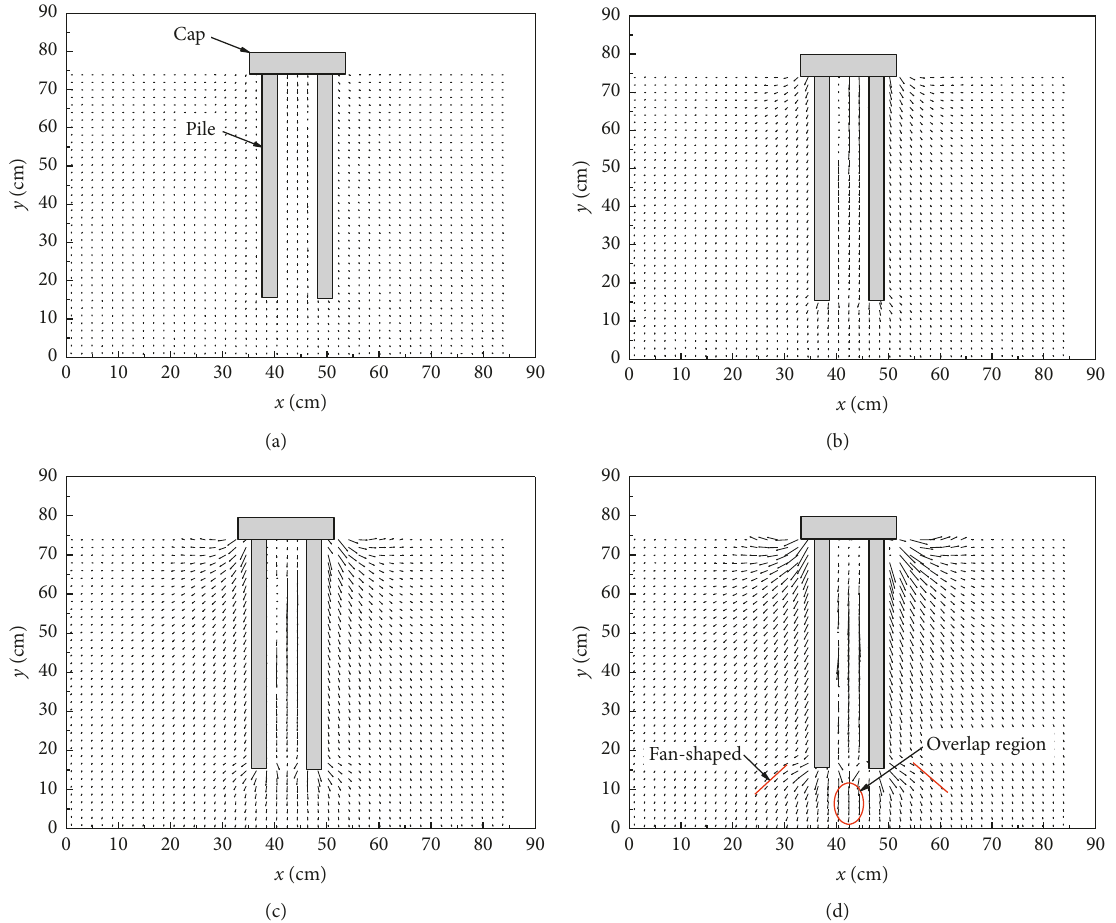
Figure 6: Soil displacement field of the pile group with 3 b pile spacing. (a) S � 1.9225mm. (b) S � 4.9850mm. (c) S � 10.15mm. (d) S �